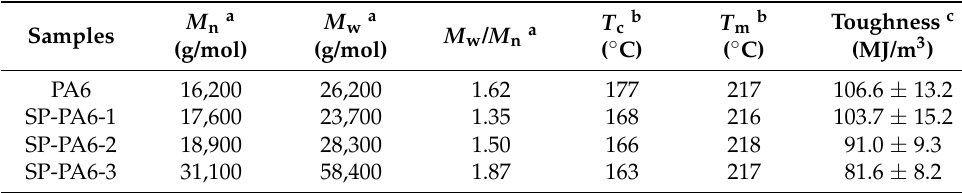
Table 2. Characteristics of pure PA6 and photochromic PA6.